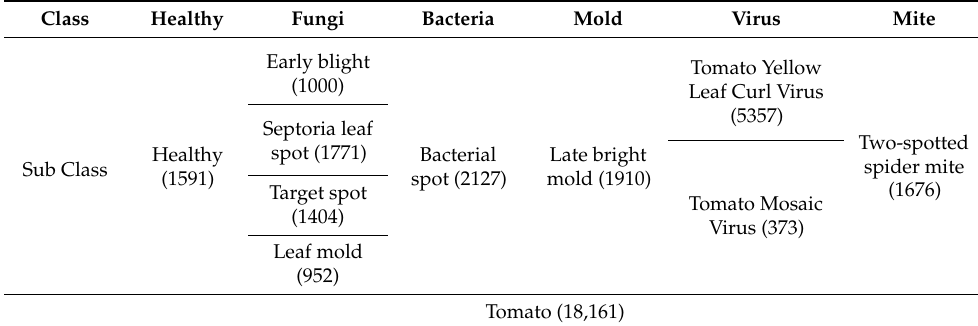
Figure 4. Sample images of healthy and different unhealthy tomato leaves from the Plant Village database. Table 2. The number of tomato leaf images for healthy and different unhealthy